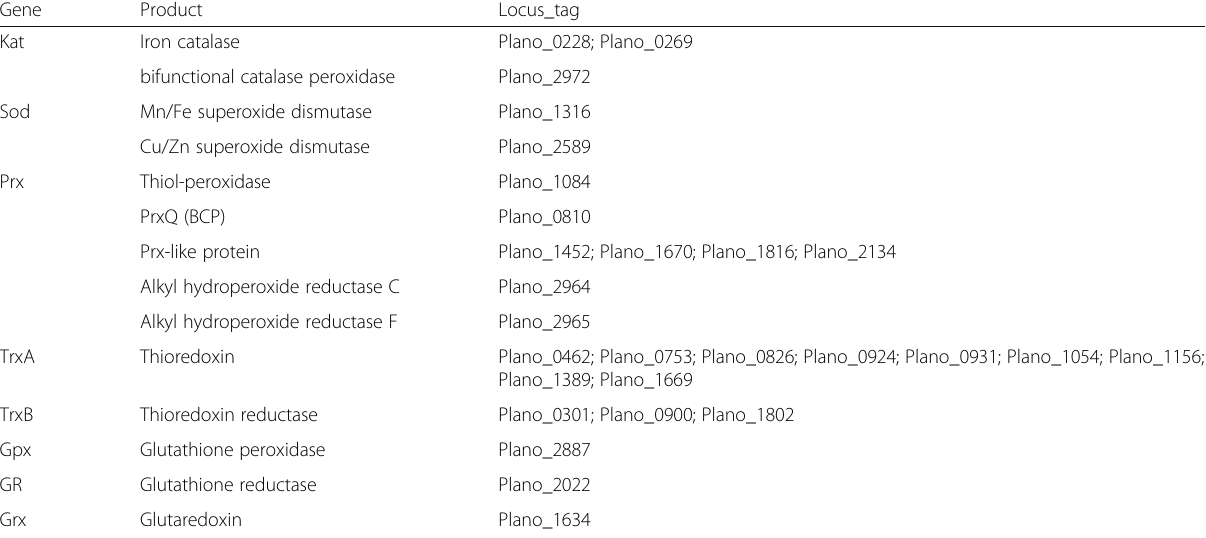
Table 6 Identified oxidative stress response related genes in